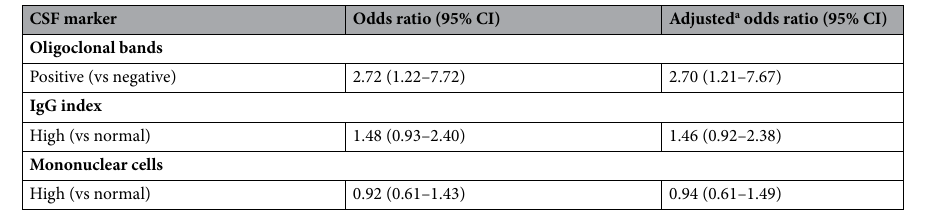
Table 3. Odds ratios and 95% confidence intervals for the odds of having “positive” or “high” CSF values in the pediatric-onset patients compared to the adult-onset patients (reference group). a Adjusted for sex and region of Sweden.